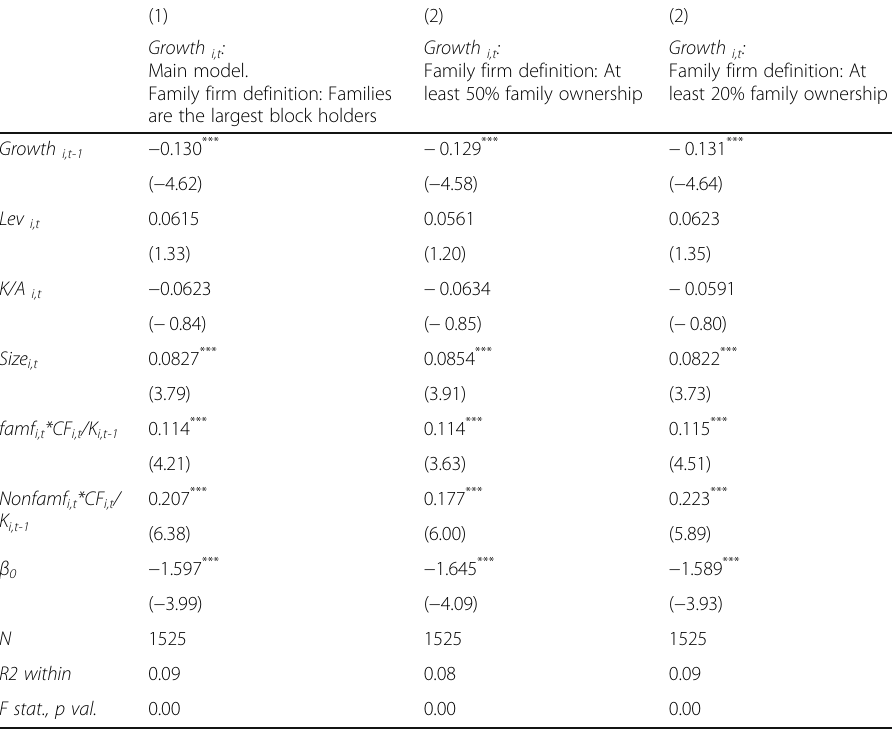
Table 3 Preliminary Analysis: Panel Fixed Effects Regressions (1) (2) (2) Growth i,t : Main